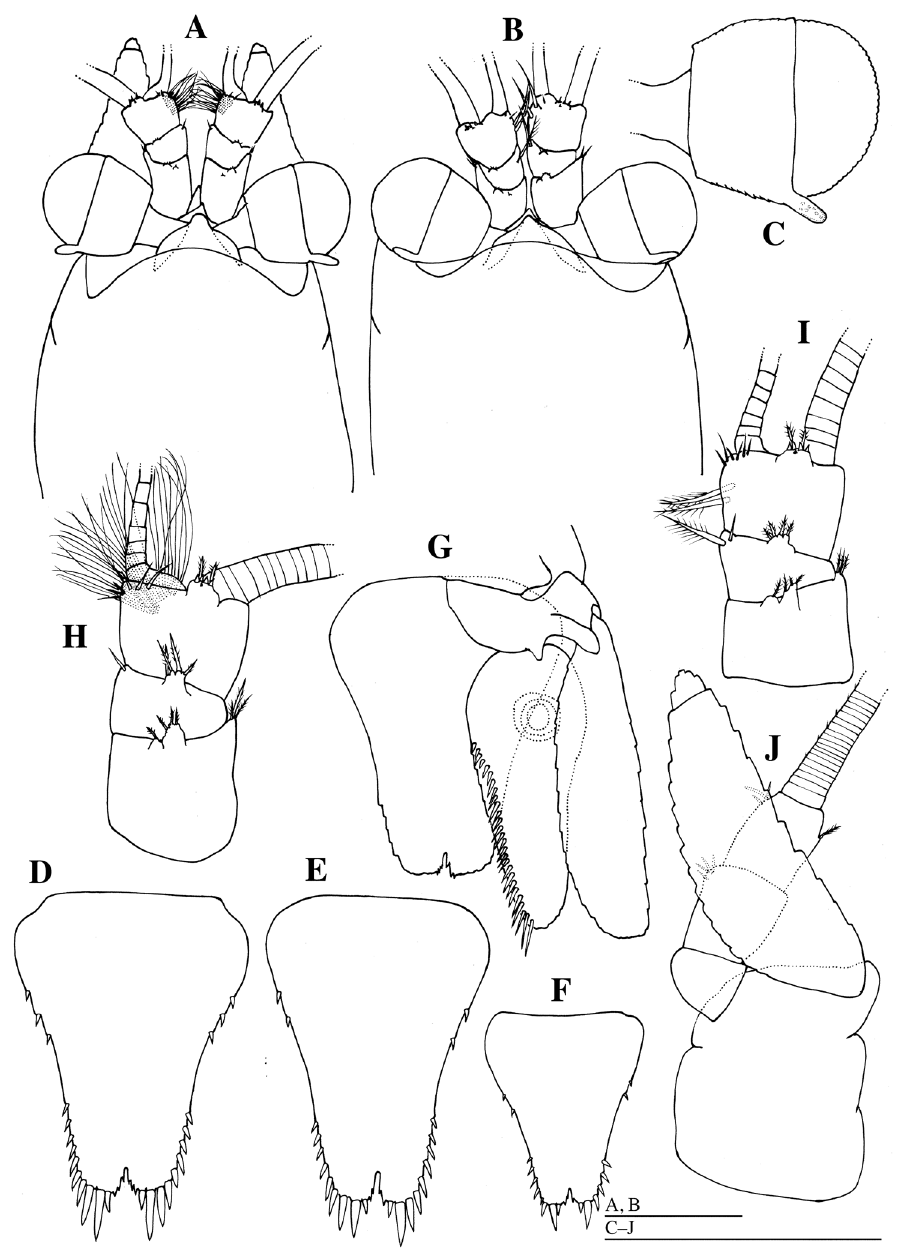
Figure 2. Mysidella hoshinoi sp. n., A, C, D, G, H, J holotype male B, E, I paratype female (KMNH IvR 500894) F paratype female (KMNH IvR 500895): A, B anterior part of head, dorsal C right eye, dorsal D–F telson, dorsal G telson and left uropod, ventral H, I basal part of right antennula, dorsal J basal part of right antenna, dorsal. Scale bars: 500